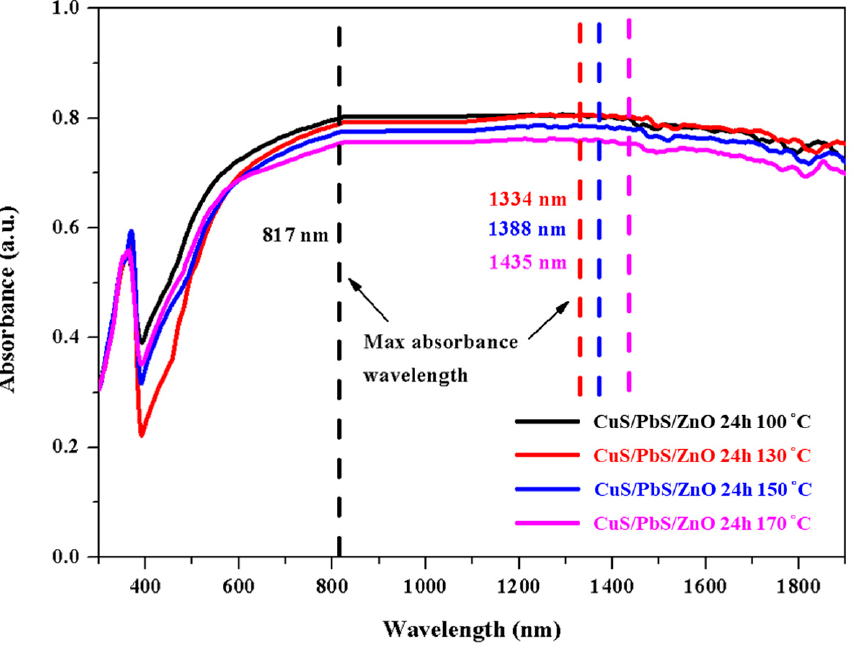
Figure 3. UV-VIS-NIR spectra of CuS/PbS/ZnO photocatalysts prepared at various hydrothermal temperatures. Dotted lines indicate the maximum absorption wavelength of photocatalysts.